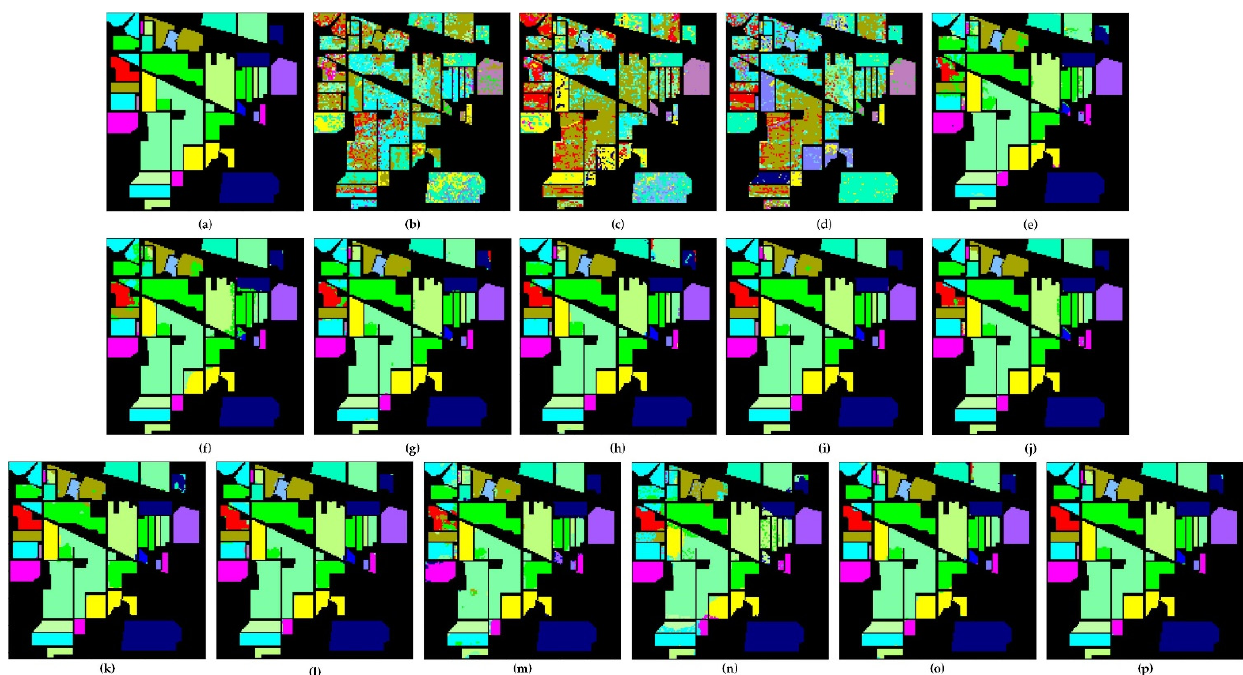
Figure 17. Classification maps on the IP dataset. ( a ) Ground truth. ( b ) SVM. ( c ) RF. ( d ) MLR. ( e )